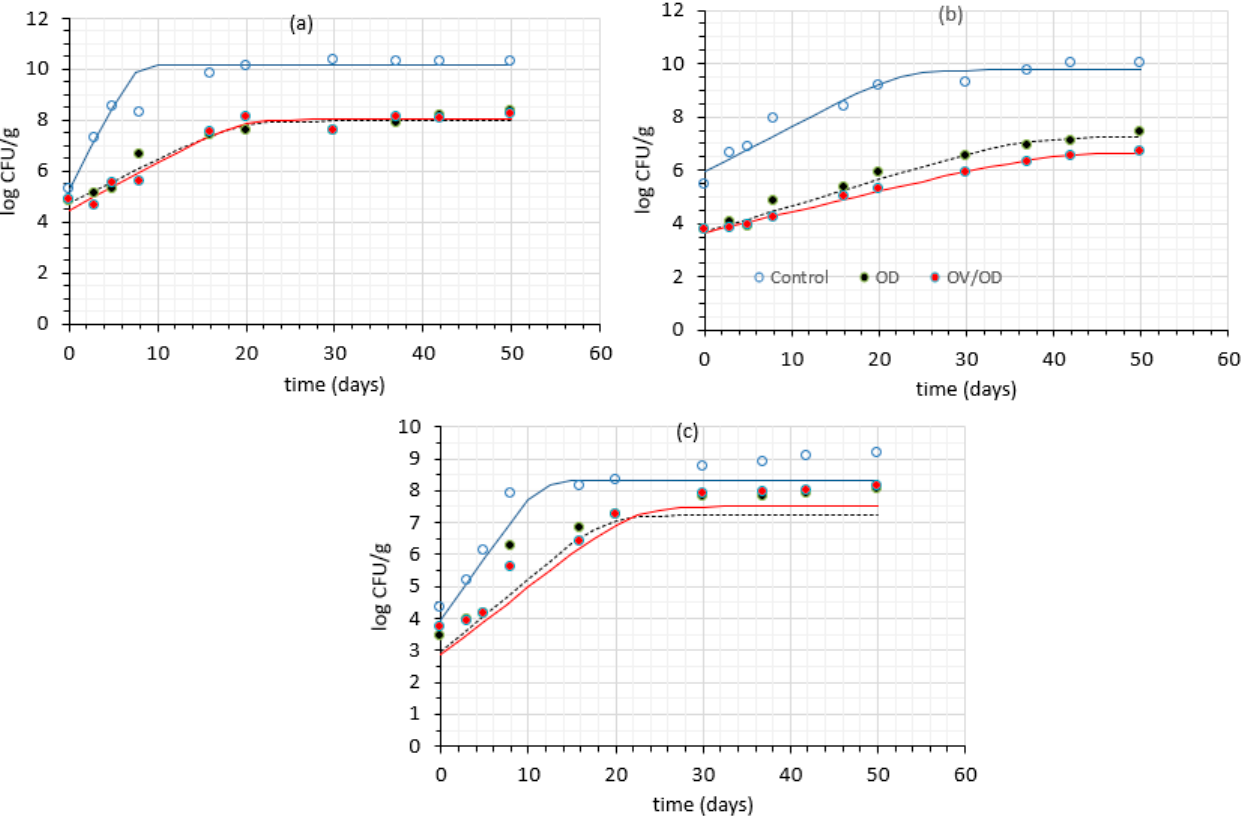
Figure 4. Microbial growth of ( a ) total viable count, ( b ) psychrotrophic bacteria and ( c ) LAB for all samples stored at 4 °C.